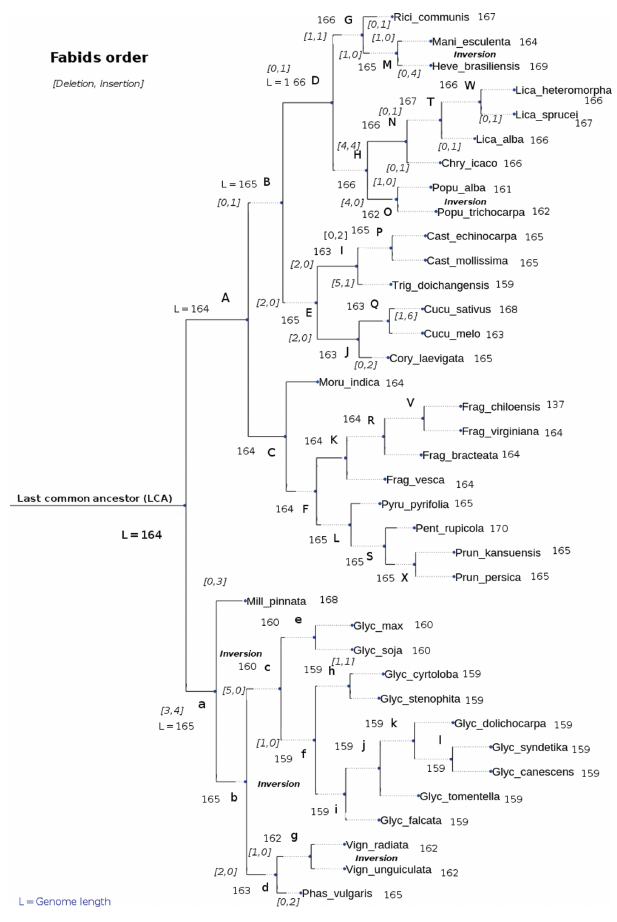
Figure 9: A phylogenetic tree in the reconstruction of the Fabids ancestor and the unambiguous reconstruction accuracies of our algorithms on this tree.